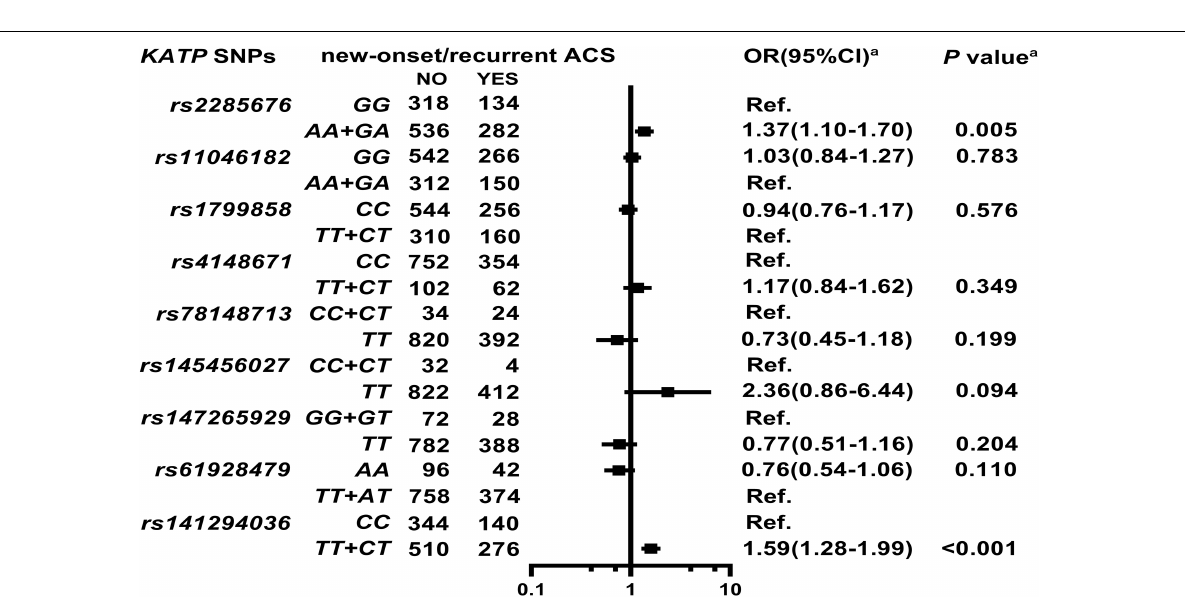
Frontiers in Cardiovascular Medicine |